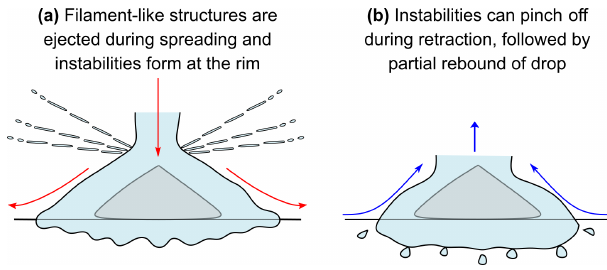
Figure 2. A schematic diagram of a supercooled water drop im- pact on an ice particle on a glass slide and subsequent secondary drop formation during (a) the spreading phase and (b) the retraction